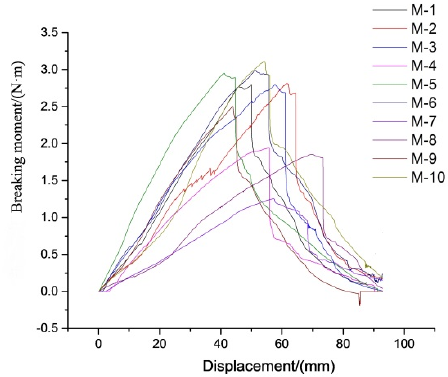
Figure 5. C2 group of bending moments.